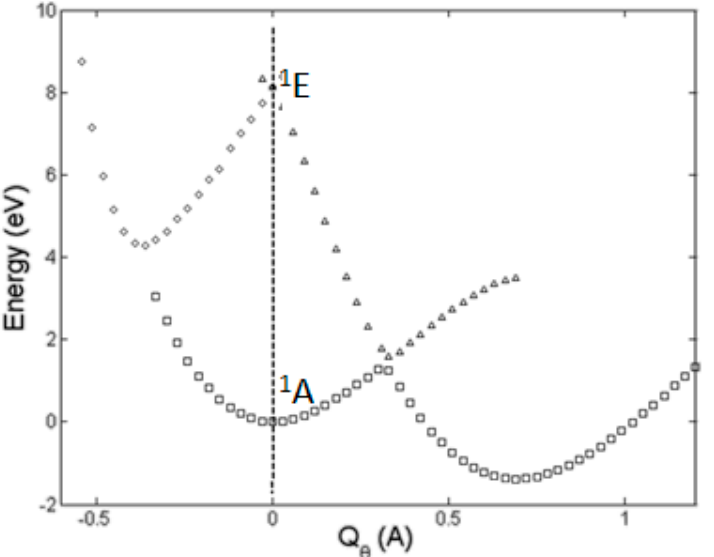
Figure 2. Cross-section of the APES of the ozone molecule along the Q θ component of the double degenerate e mode obtained by numerical ab initio calculations of the ground 1 A and highly excited 1 E state, explicitly demonstrating that the ground state distorted configurations are due to the JTE in the excited state [7]. In the global minimum at Q θ = 0.69 Å the molecule has a significant dipole moment, and the E - A avoided crossing takes place at Q θ ~0.35